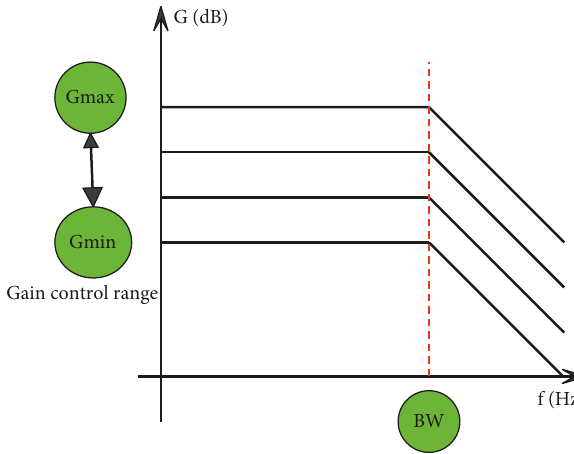
Figure 7: Amplitude-frequency characteristic curve of an ideal VGA.